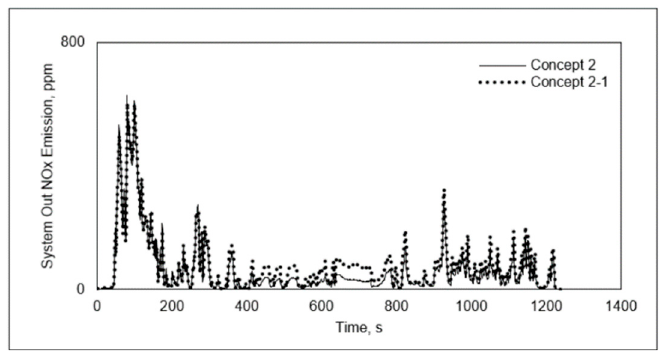
Figure 12. System out NOx emission during NRTC with different SCR substrate concepts.